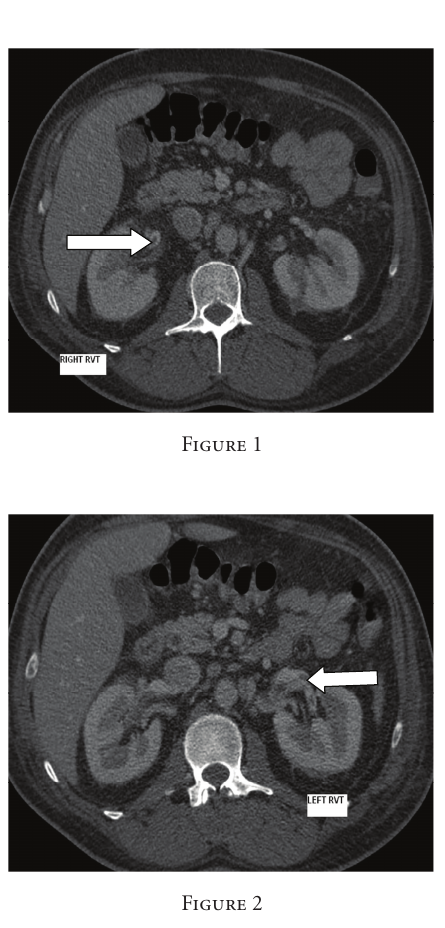
Figure 4: CT angiogram with no thrombus after 1 week of